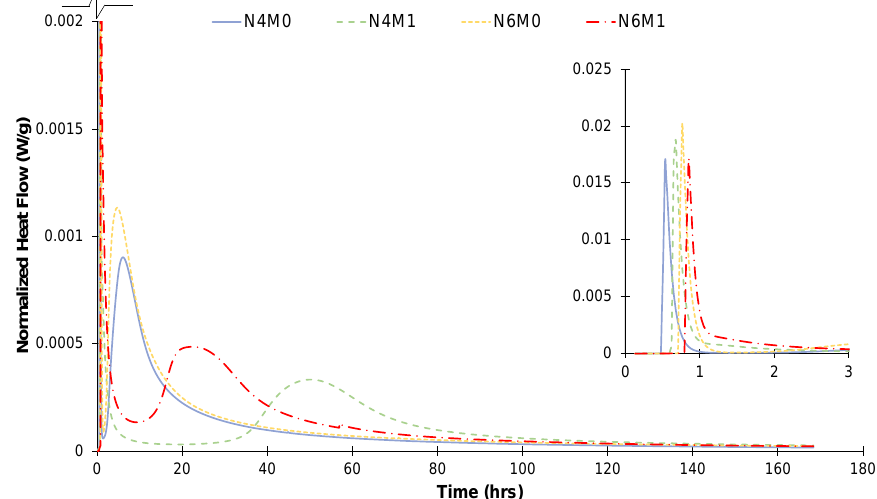
Figure 5. Effect of activators on heat evolution of natural aggregate mortars.